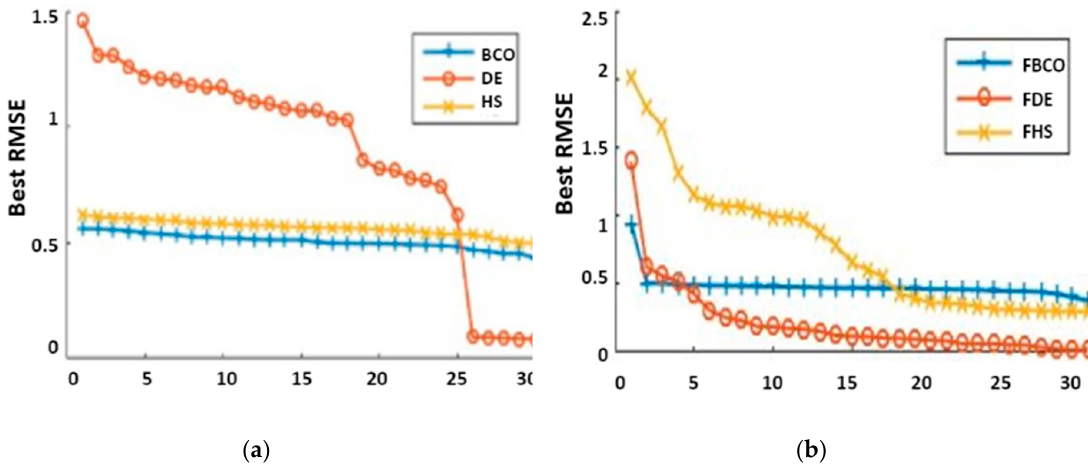
Figure 18. Comparison of the RMSE for each method for the inverted pendulum on a cart controller: ( a ) original algorithms, and ( b ) fuzzy algorithm.